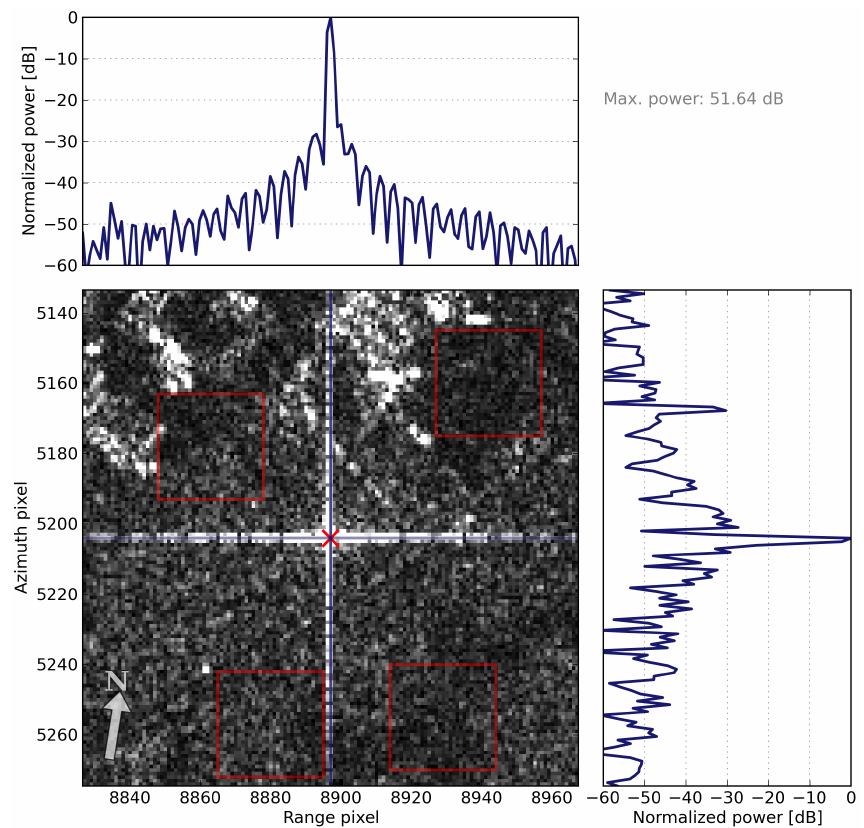
Figure 5. Transponder impulse response for the first overpass on 7 April 2013. A large target-to-clutter ratio is apparent. The four red squares indicate the areas from which the clutter power was